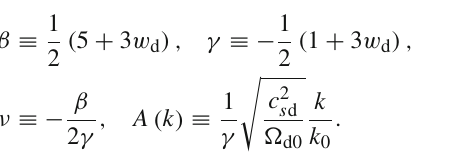
the gravitational potential shown on the right panel plot of Fig. 4. As can be seen, the asymptotic behaviour for large scale factors, given in 7 Eq. (20), coincides with the solution for a , Eq. (18). However, instead of having just the vanishing c 2 s d constants terms C 1 , and C 2 , the solutions for non-vanishing (cid:6)= 0 parameter keep some information of the modes c 2 s d through the function A ( k ) and modulated by the constants D 1 , and D 2 . Note that the dominant solution for x → ∞ is constant as long as the coefficient β is positive,